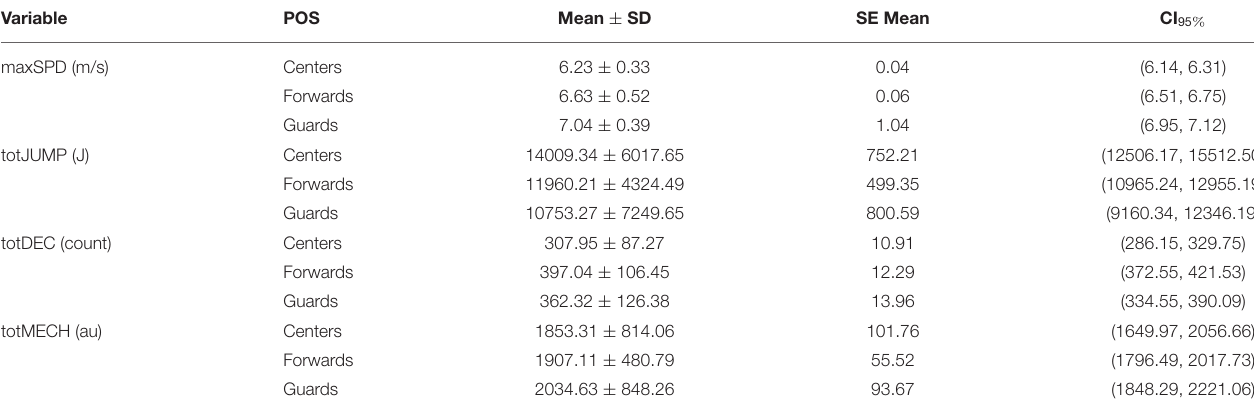
TABLE 3 | Primary external load variables for Centers ( n = 64), Forwards ( n = 75), Guards ( n = 85). Variable